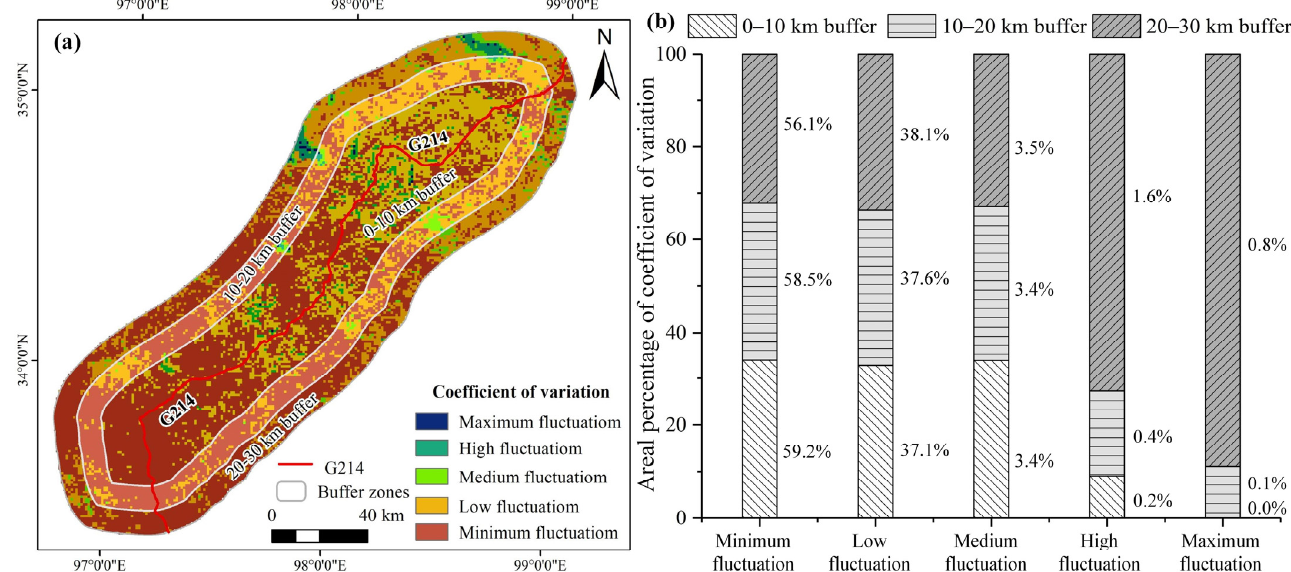
Figure 4. Coefficients of variation (CV) of growth season Normalized Difference Vegetation Index (NDVI gs ) within the three buffer zones along National Highway G214 from Changshitoushan Mountain Pass to Qingshui’he Riverside at the northern and southern flanks of the Bayan Har Mountains, southern Qinghai, China, from 2010 to 2019. Notes: ( a ) Spatial stability distribution of coefficients of variation within the 0–30 km buffers; ( b ) Areal percentage of coefficient of variation in the three buffer zones.